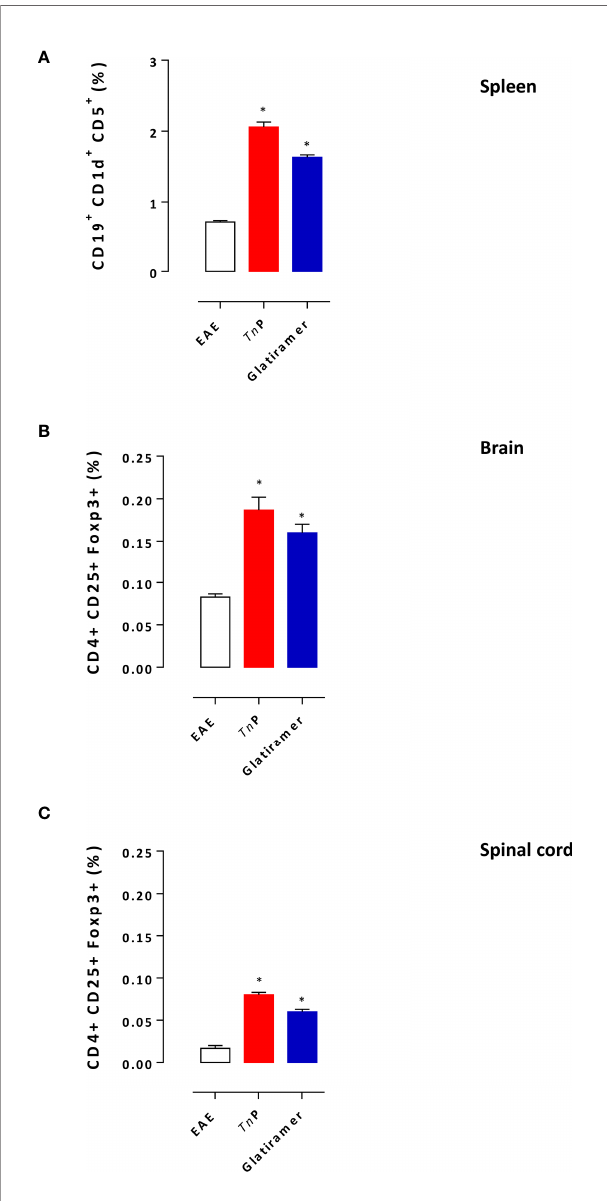
FIGURE 4 | Tn P increases the expansion of regulatory cells. Splenocytes isolated at day 7 (A) and CNS-in fi ltrating leukocytes isolated at the peak of disease (17 day) from pooled brain (B) and spinal cord (C) homogenates of EAE mice treated with vehicle, Tn P or glatiramer were evaluated for the percentage of Breg or Treg after acquisition of 100,000 events as shown in the schematic image of Supplementary Figure 1B, C . Data represent mean ± SEM. * p < 0.05 compared with vehicle-treated EAE